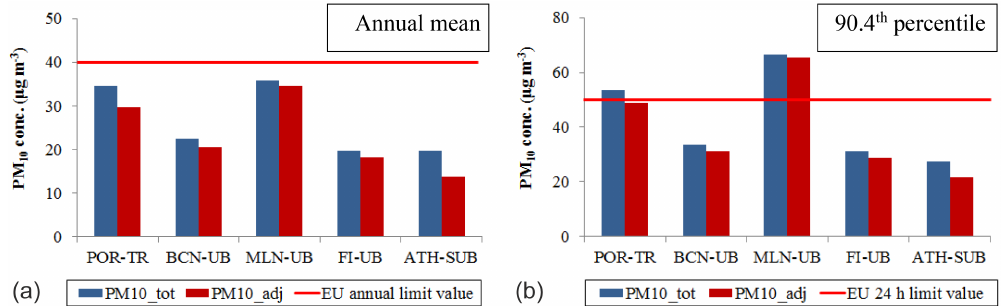
Figure 2. Annual mean (left) and 90.4th percentile (right) of PM 10 concentrations (PM10_tot) and the respective adjusted concentrations after subtracting the contribution of natural sources (PM10_adj), for all AIRUSE sites. Red lines denote the annual (40µgm − 3 ) and 24h limit value (50µgm − 3 ) set by the EU (Directive 2008/50/EC).